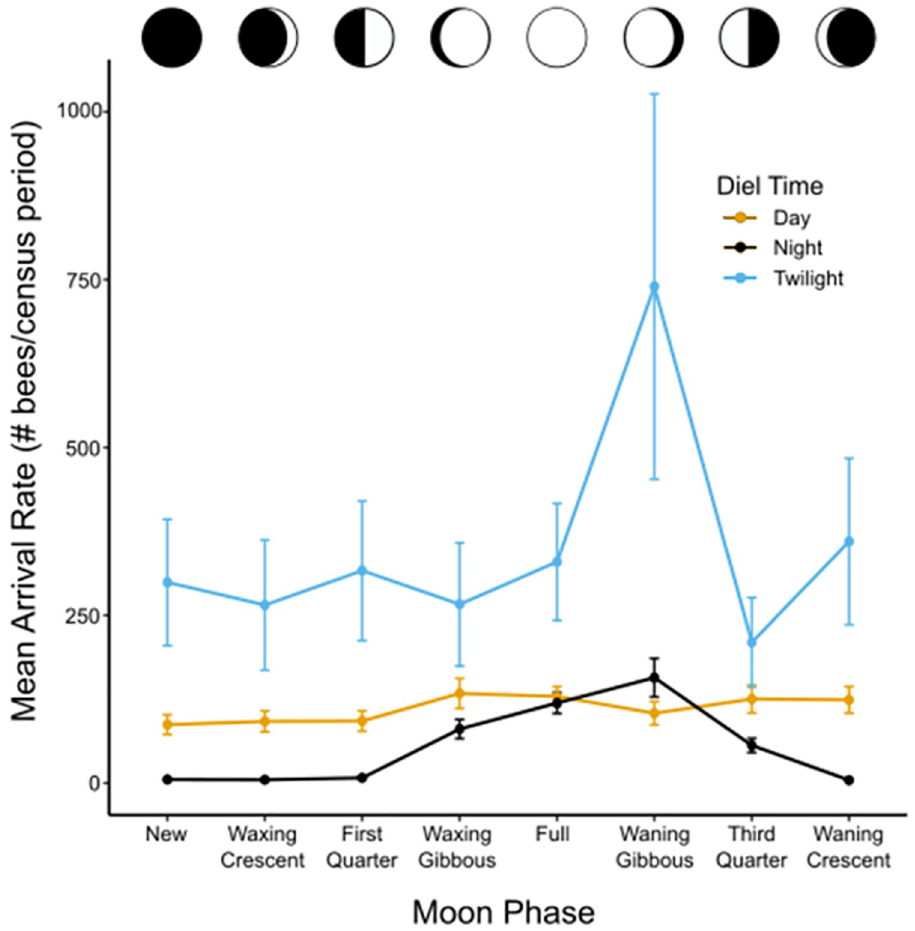
Fig 5. Estimated marginal mean arrival rates across moon phases. Estimated marginal mean arrivals rates during different diel times are shown across moon phases. Activity was consistently the highest and equal during the day and twilight (all P > 0.05) except during the waning gibbous and waning crescent moons ( P < 0.05) where more activity was seen during twilight time periods. Nocturnal activity was generally low compared to activity the rest of the day ( P < 0.05), except the moon phases including and between the waxing gibbous and third quarter moons, where it was equal to activity seen during the day ( P > 0.05). Error bars represent 95% confidence intervals. Data shown here stem exclusively from observations of A . dorsata Colony 4, and include only data collected during the lunar cycle observation periods from January 21, 2019 –February 19, 2019 and March 21, 2019 –April 19, 2019.